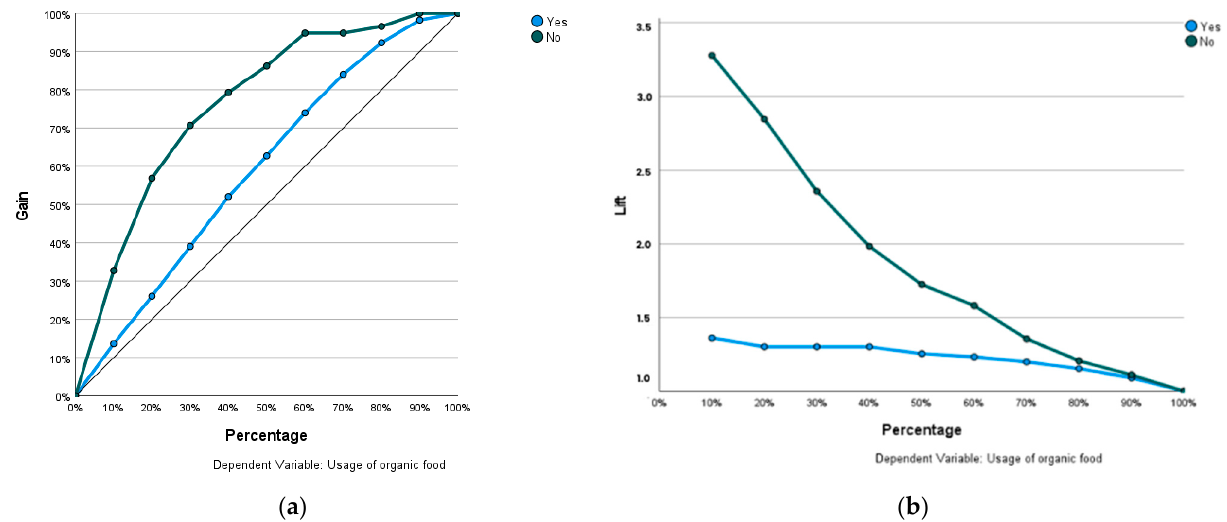
Figure 4. Model performance measurement: ( a ) Cumulative gains of the ANN3 model; ( b ) Lift chart showing model performance in a portion of the population; Source: Author’s work, using SPSS.